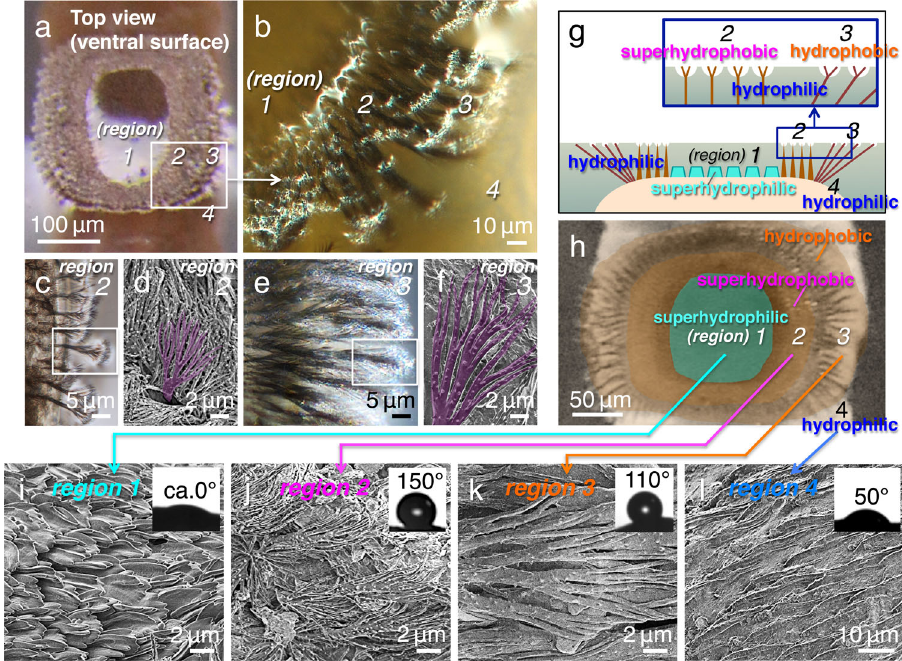
Fig 2 Observations of the crown-like structures in the larvae. a Stereo dissecting microscopy and b differential interference microscopy images of the crown. c , e High-magni fi cation differential interference microscopy images of the tips of the hairy crown structures underneath the water surface in regions 2 in c and 3 in e . d , f SEM images of areas corresponding to the white rectangles in c and e , respectively, obtained from samples prepared via the NanoSuit method for living specimens. g , h Schematic images showing four regions with different wettabilities (1-4): cross-sectional view in g and top view in h . i – l SEM images of these regions in specimens prepared using the NanoSuit method. Water contact angle measurements are shown in the insets.